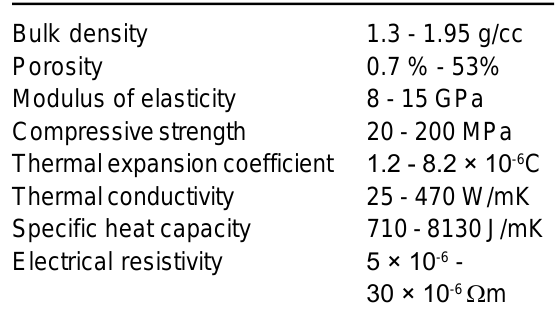
Table 2. General properties of graphite, adapted from